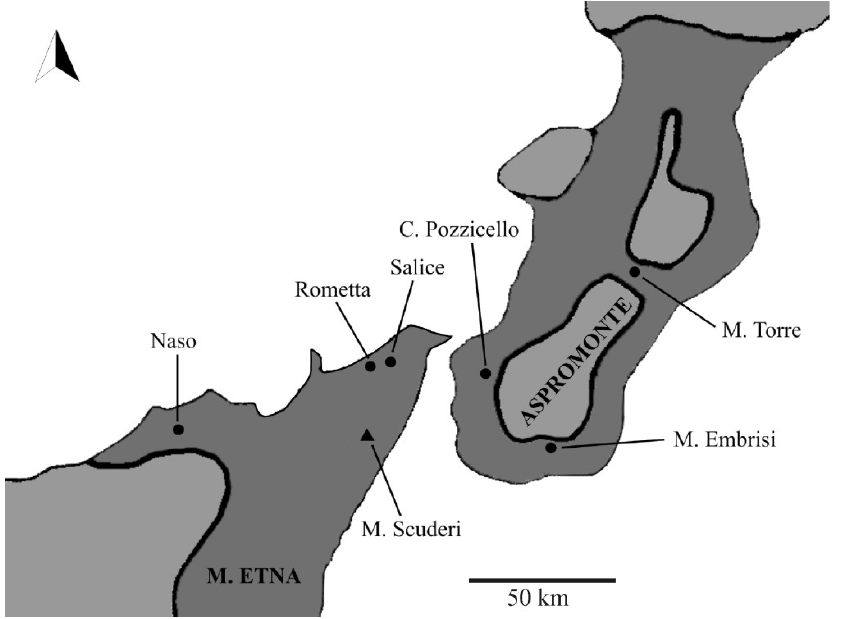
Figure 1. Lower Pleistocene palaeogeography of North-Eastern Sicily and Southern Calabria. Dark gray: deposits of bathyal environment. Light gray: lands. Modified after Bonfiglio and Mangano